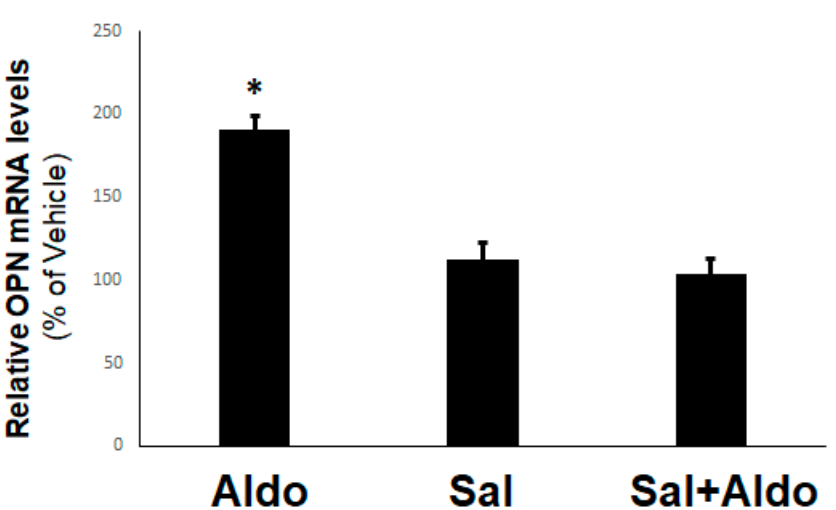
Figure 1. β 2 -adrenergic receptor (AR) inhibits aldosterone-induced osteopontin (OPN) upregulation in H9c2 cardiomyocytes. H9c2 cells were treated with 10 nM aldosterone (Aldo), 10 µM salbutamol (Sal), or 10 nM aldosterone in the presence of 10 µM salbutamol (Sal+Aldo) for 2 h. At the end of this